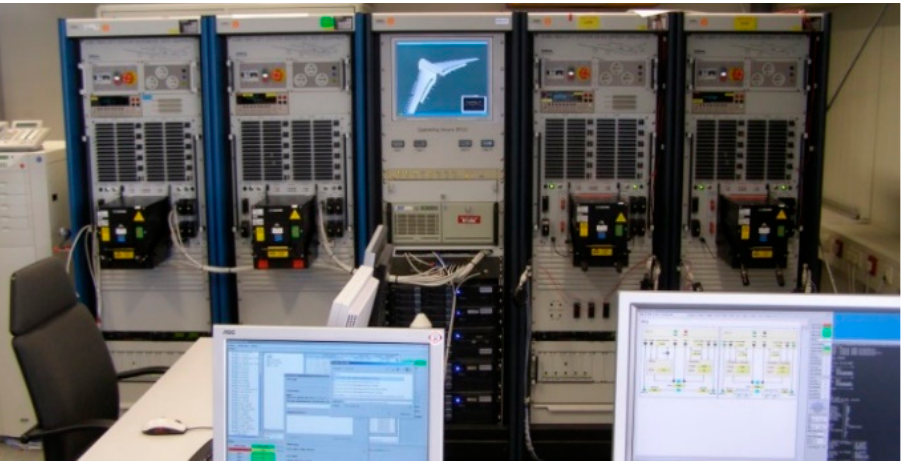
Figure 2. A380 Test Bench-Image from Airbus Operations GmbH.